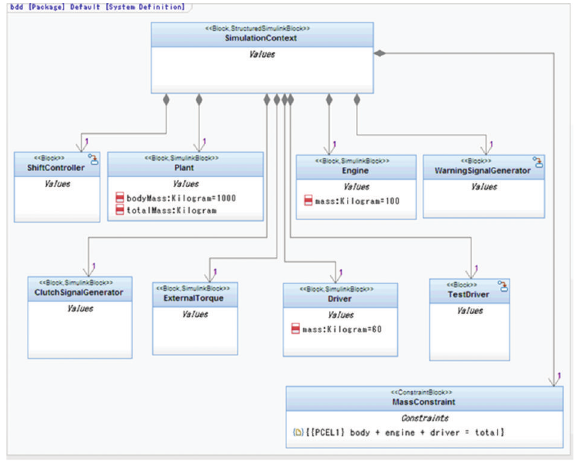
Figure 12: Simulation context.